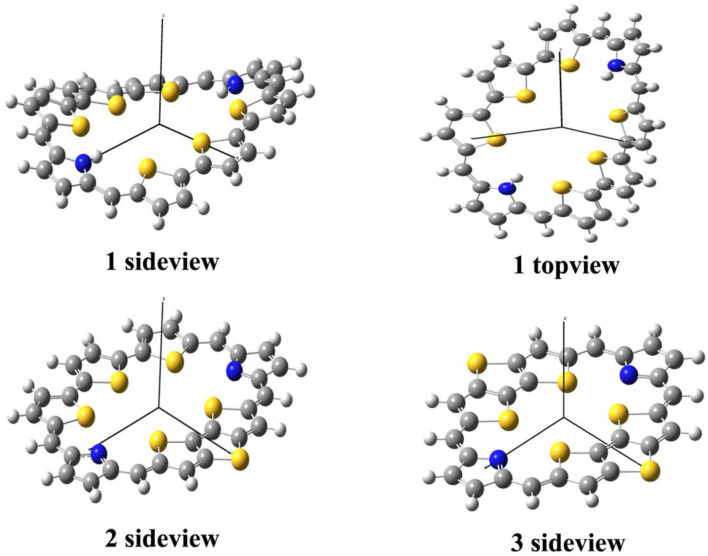
Optimized molecular structures of 1–3 in their ground states.